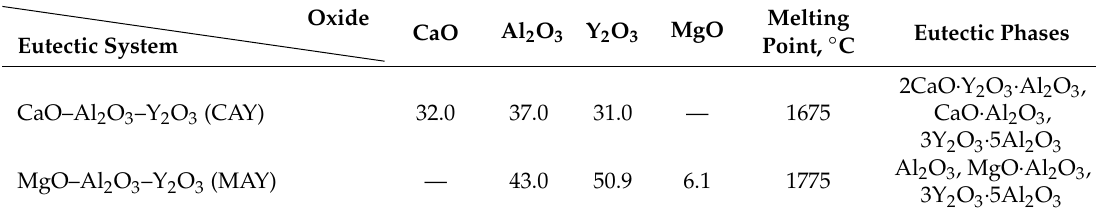
Table 1. Compositions (% wt.) and melting points of eutectic batches (°С) [17].